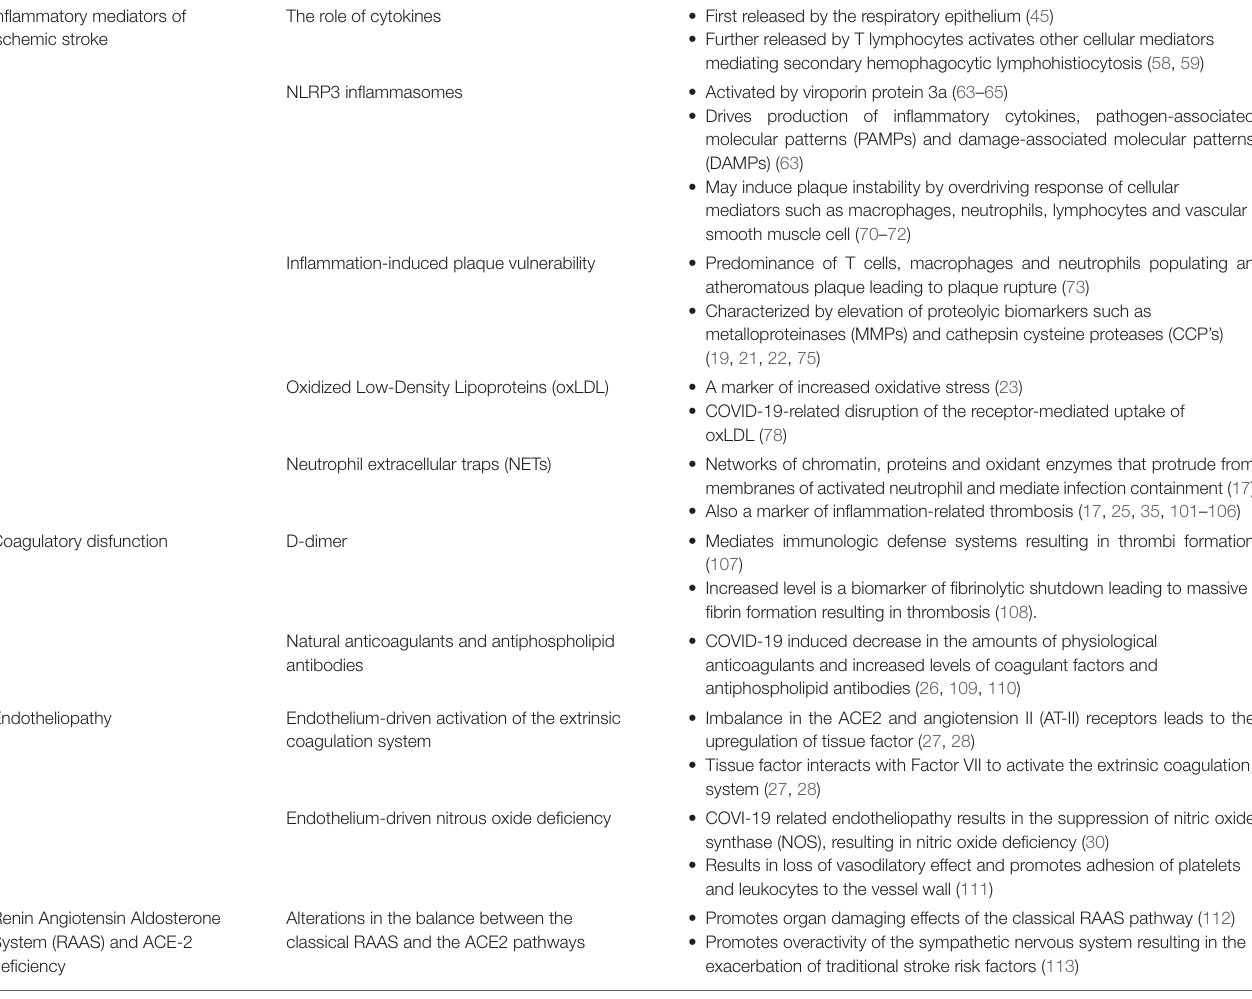
TABLE 3 | Summary of Pathophysiological mechanisms of COVDI-19 related Acute Ischemic Strokes. Inflammatory mediators of ischemic